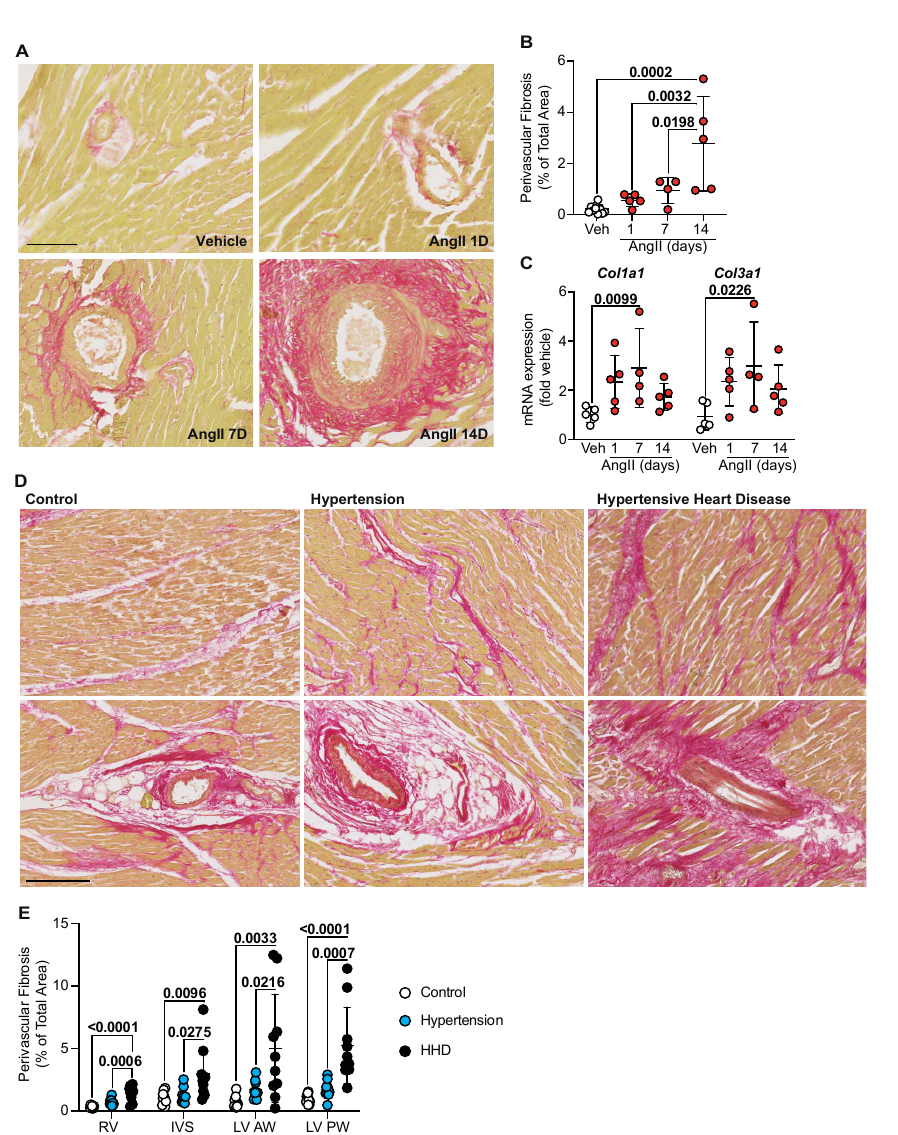
Figure 2. Perivascular fibrosis predominates in human and murine hypertensive heart disease. ( A ) C57Bl/6J wild-type mice treated with Angiotensin II (AngII; 0.8 mg/kg/day) for up to 14 days.